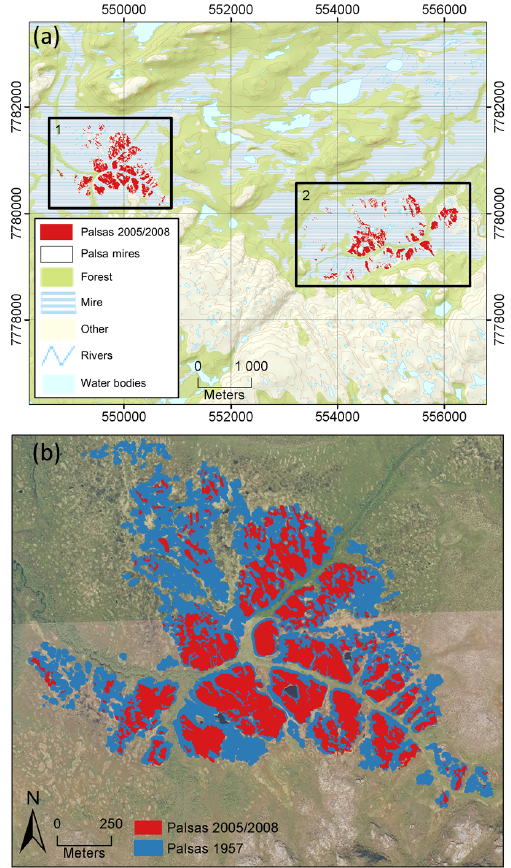
Figure 6. (a) Palsa mires mapped in Karlebotn. Background map from Kartverket (2015b) with projection in UTM 35N. (b) Palsas and peat plateaus mapped in mire 1. Background image from 2008 through Norgeibilder (2015).